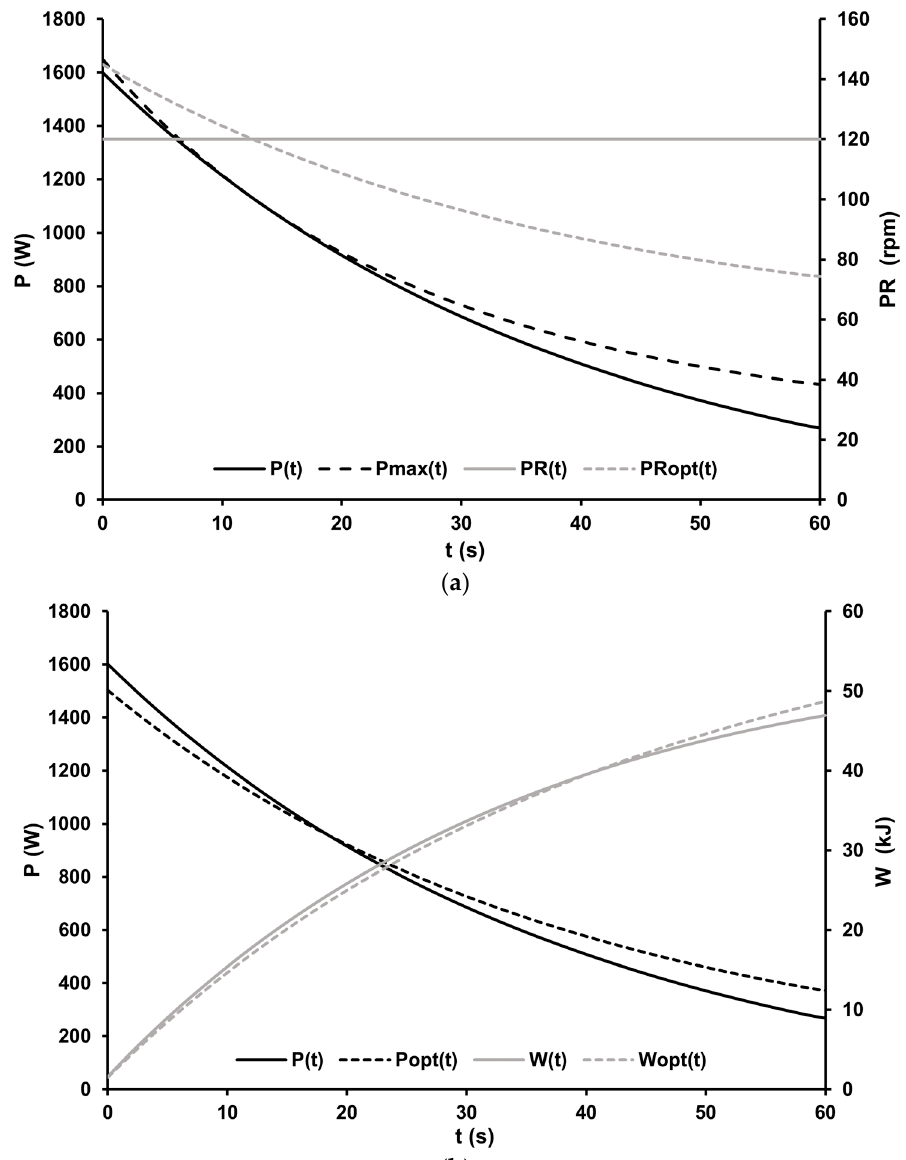
Figure 4. ( a ) Time-dependent maximal power output (P max (t)) at dynamic optimal cadence (PR opt (t)) and power output (P(t)) during a 60-s all-out sprint at a cadence of 120 rpm (PR) on a cycle ergometer. ( b ) Comparison of the time-dependent power output (P(t)) at a pedaling rate of 120 rpm and the corresponding work performed (W(t)) to optimized power output (P opt (t)) at a mean optimal pedaling rate of 102 rpm and the corresponding work performed (W opt (t)) during a 60-s all-out sprint on a cycle ergometer. In fact, free optimization of the mean power output by altering the cadence during the isokinetic test resulted in a calculated mean optimal pedaling rate of 102 rpm. Changing the cadence to 102 rpm would result in a 7% higher mean power output of the athlete in the isokinetic test mode.